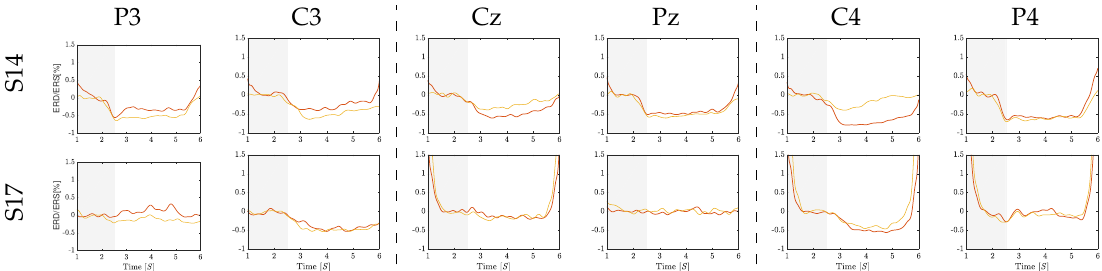
Figure 6. Exemplary ERD/ERS time-courses performed by subjects S17 and S14 for left-hand class (colored in red line) and right-hand class (in yellow) at the evaluated scalp electrodes, while using the back resting state (shadowed area) as the reference